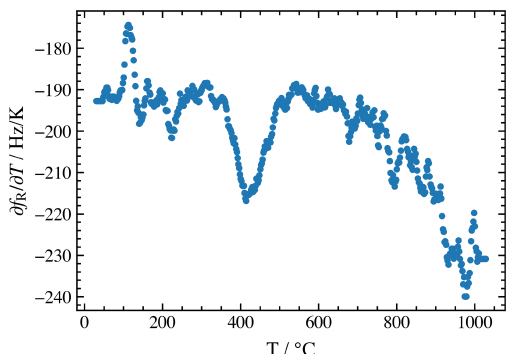
Figure 13. Comparison of the temperature reported by a type S thermocouple attached to housed CTGS resonator and the tempera- ture calculated from the resonance